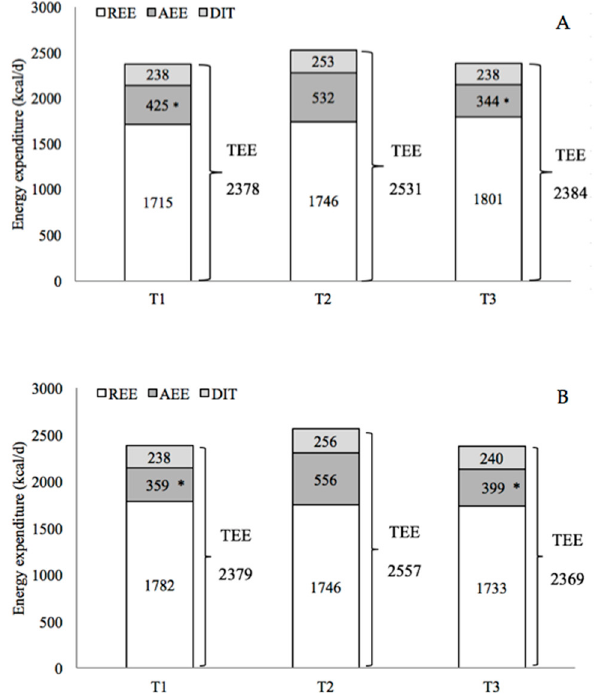
Figure 3. Mean of components of total energy expenditure (TEE) before the training period (T1), one week during training (T2), and one week after two months of the end of the training (T3). TEE: total energy expenditure; REE: resting energy expenditure; AEE: activity energy expenditure; DIT: Diet induced thermogenesis. Repeated measure Anova (*Significantly different compared to T2, p < 0.05). ( A ) EXP group; ( B ) CTRL group.